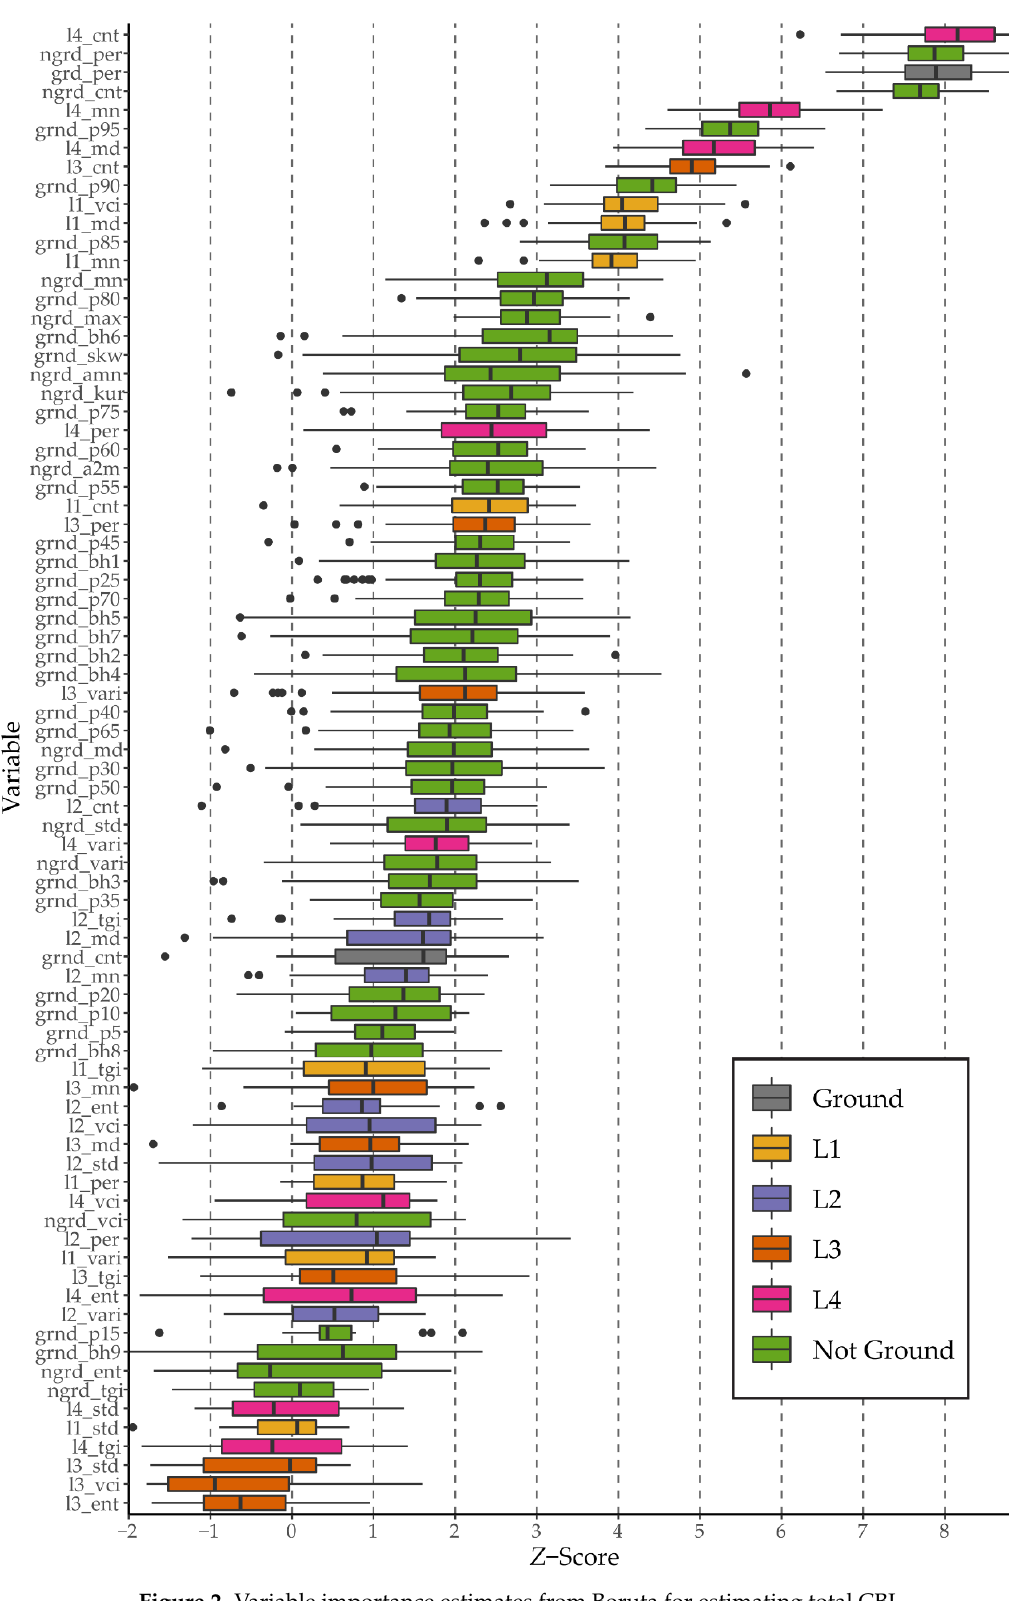
Figure 2. Variable importance estimates from Boruta for estimating total CBI.